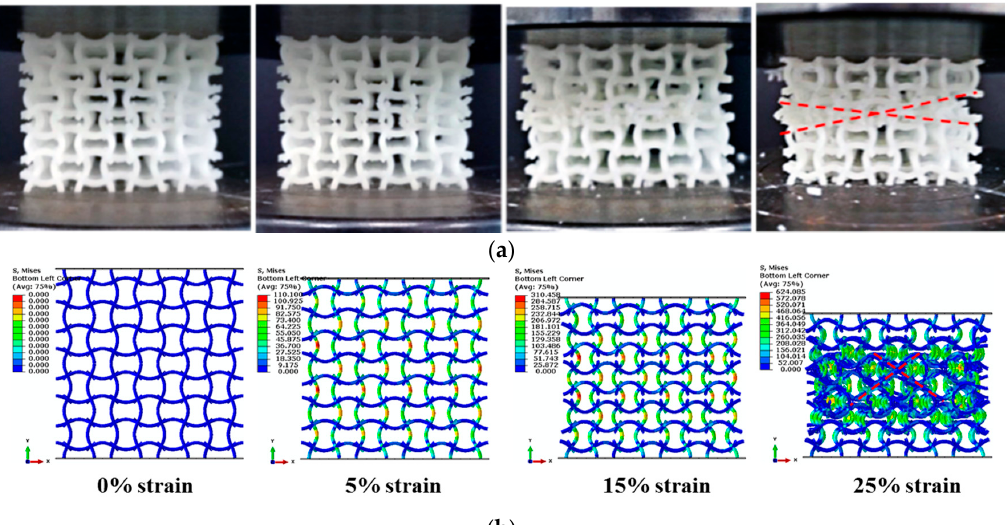
Figure 8. Front view of collapse modes of the NPR CCF2 under quasi-static uniaxial compressions in the y direction: ( a ) experiment; ( b ) numerical simulation (until 25% strain).